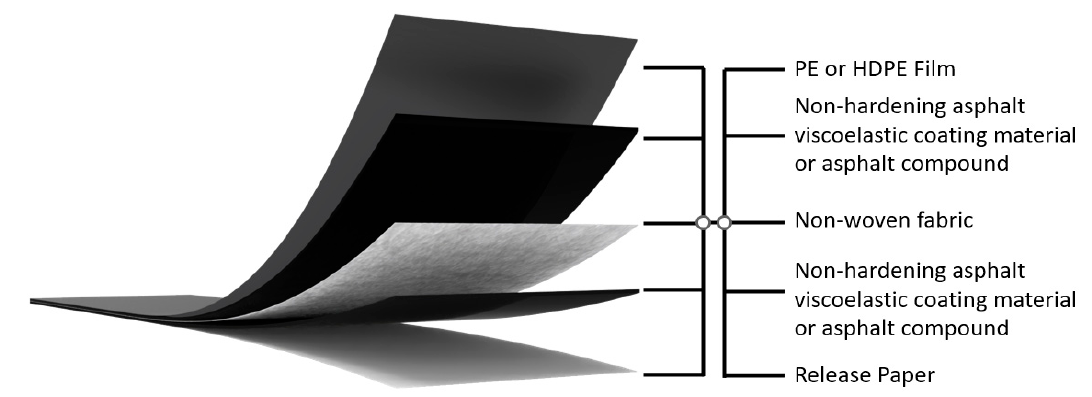
Figure 1. The basic structure of the NHV-SPRG composite waterproofing sheet .